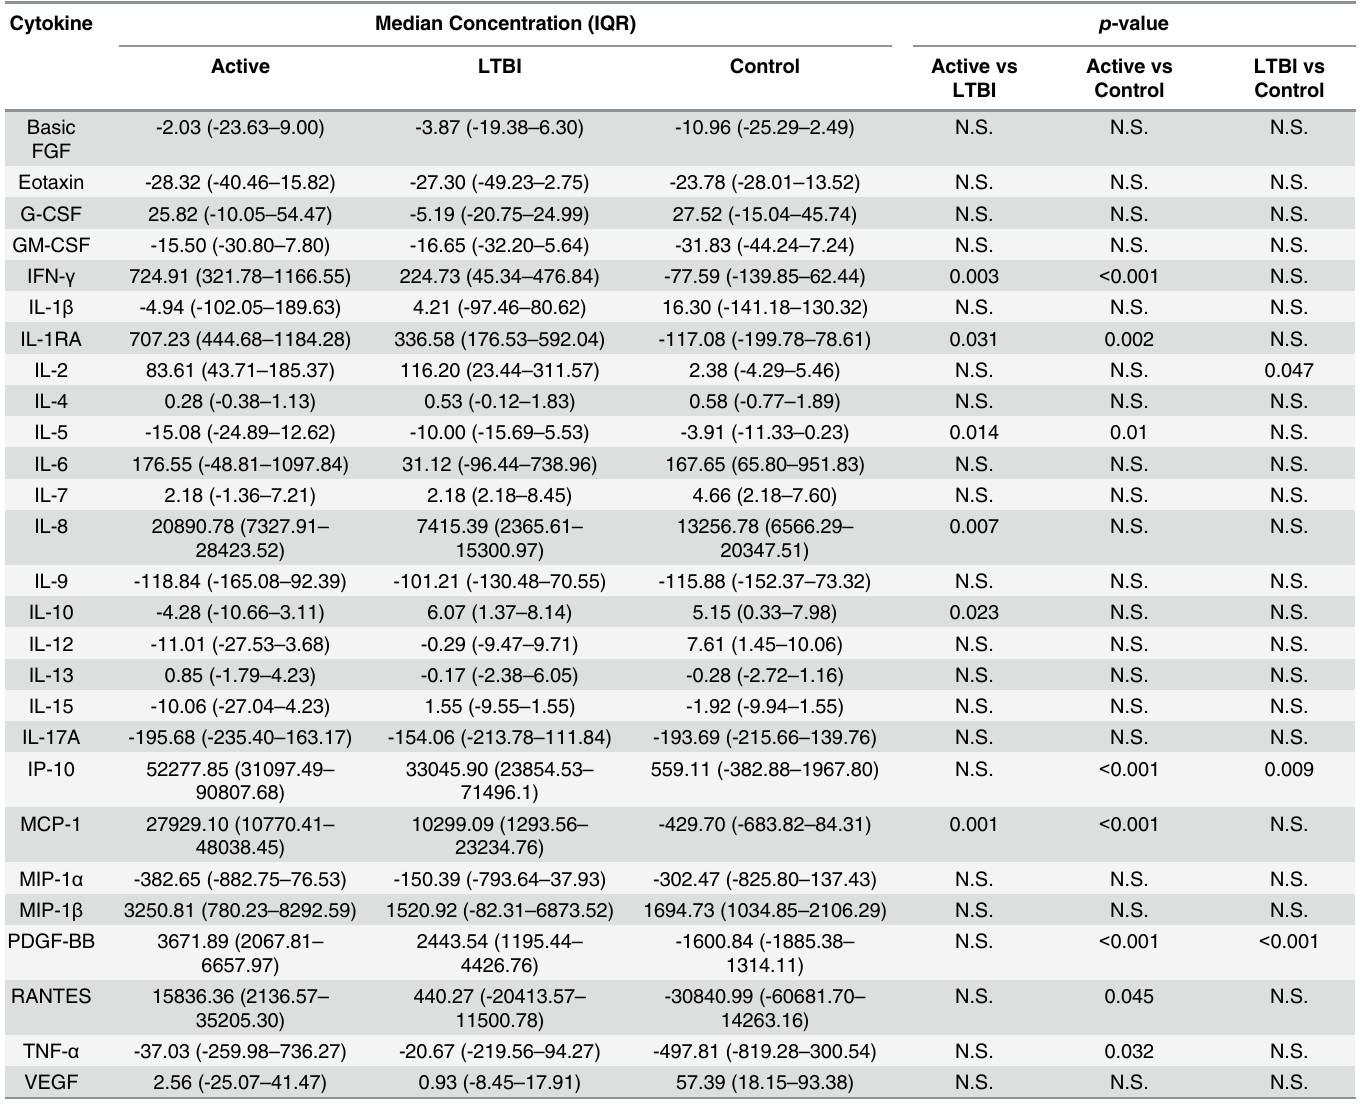
Table 2. Concentrations of cytokines in the three groups (TBAg –